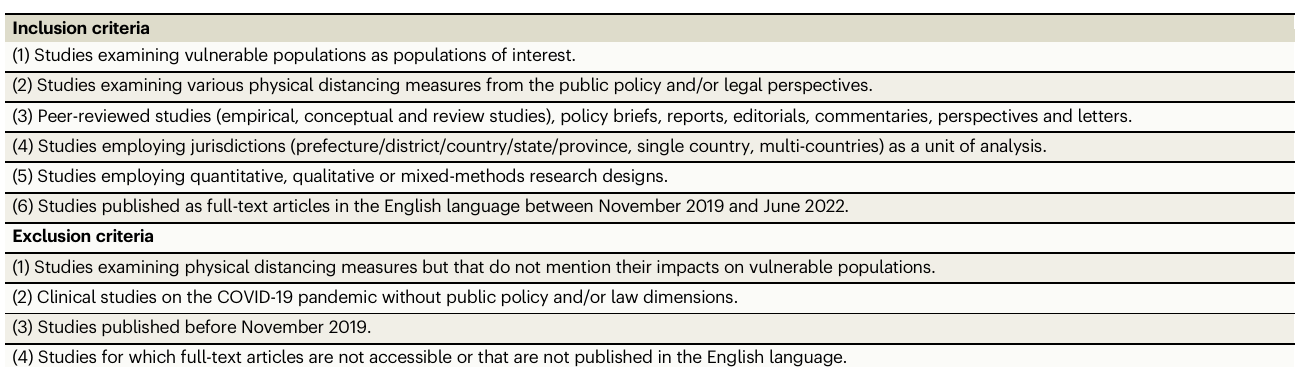
Table 5 | Inclusion and exclusion criteria for screening of relevant studies Inclusion